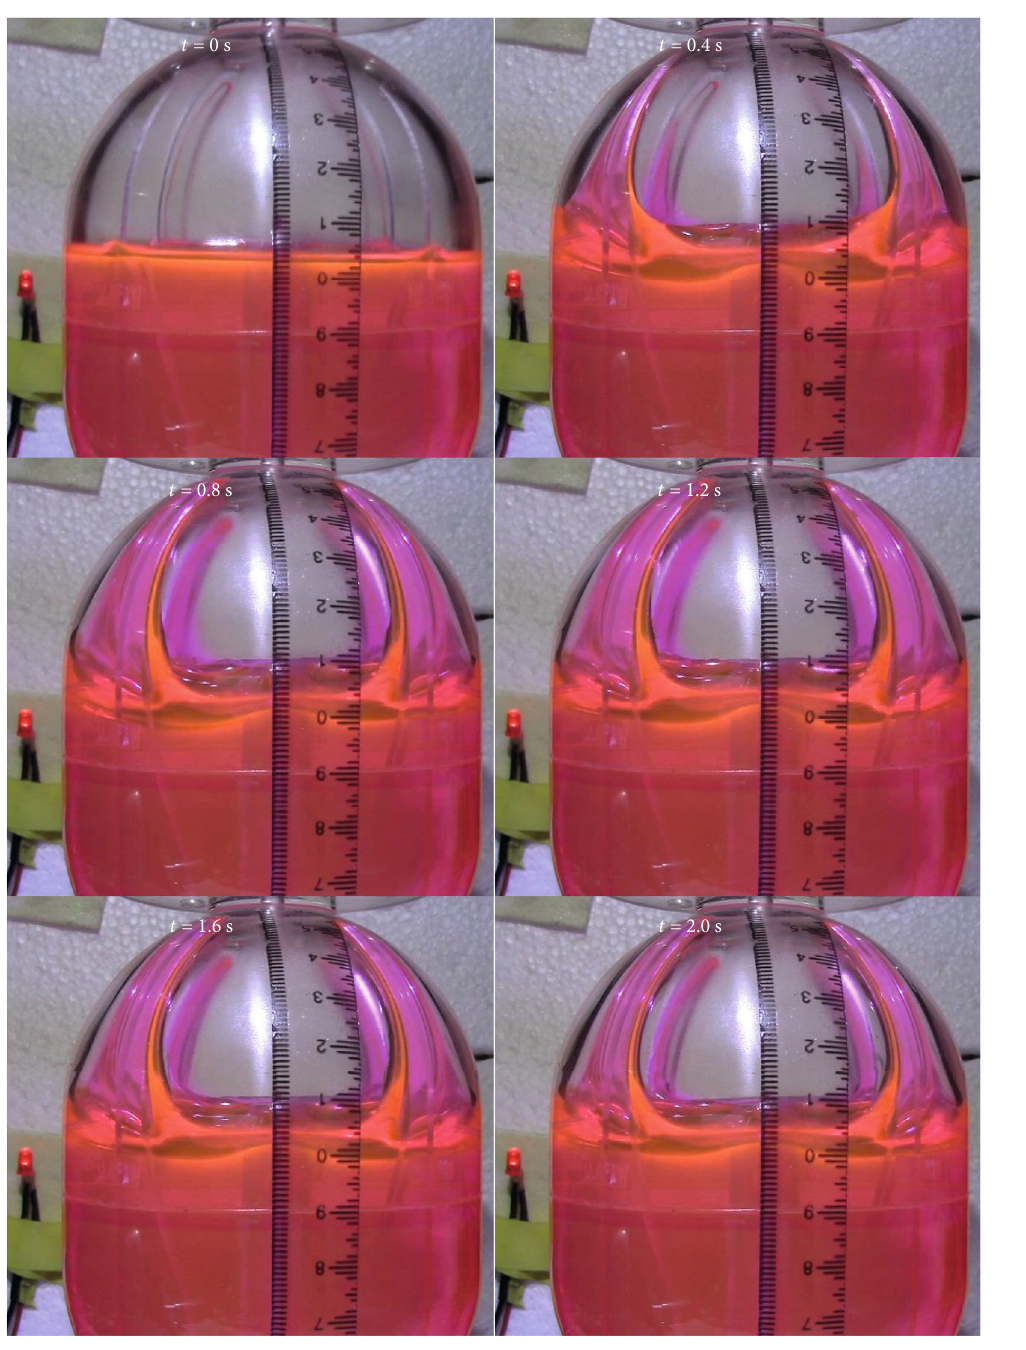
Figure 9: Liquid volume fraction is